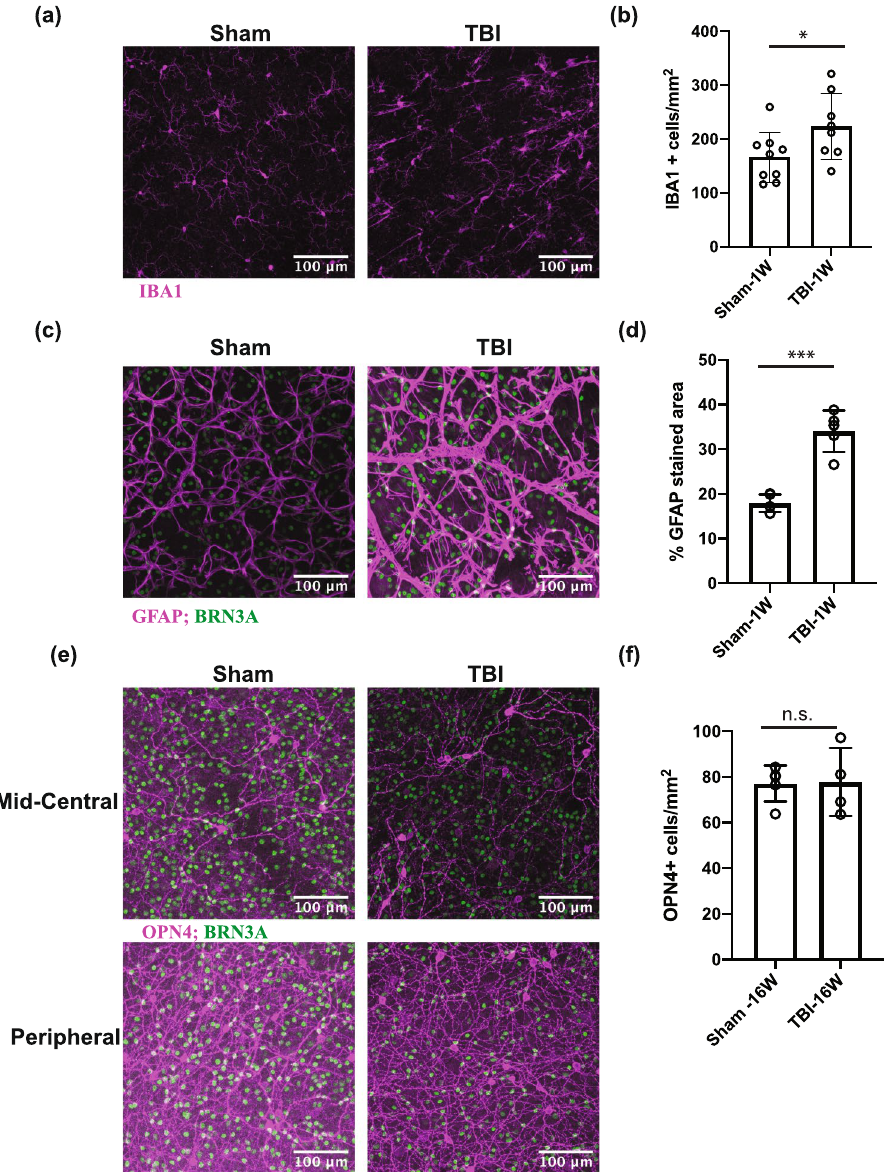
Figure 7. Blast-mediated injury resulted in a significant increase in the number of microglia in the retina within one week. ( a ) Images from the mid-central area of whole-mount retinas stained with anti-IBA1 antibody (pink) at 1 week (1 W) post-injury, for sham and bTBI-treated mice. ( b ) Quantification of IBA1 + cells at 1 W after injury. ( c ) Images from the mid-central area of whole-mount retinas stained with anti-GFAP antibody (pink) and anti-BRN3A antibody (green) at 1 W post-injury, for sham and bTBI-treated mice. ( d ) Quantification of GFAP + area 1 W after injury. ( e ) Images from the mid-central and peripheral areas of whole- mount retinas stained with anti-OPN4 antibody (pink) and anti-BRN3A antibody (green) at 16 weeks (16 W) post-injury for sham and bTBI-treated mice. ( f ) Quantification of OPN4 + positive cells at 16 W after injury. Bars represent mean ± SD and each data point represents a biological sample; unpaired two tailed t -test analysis with Welch’s correction, * p < 0.05, ***p<0.001, n.s. not significant. The images were processed in Fiji 111 , the graphs were generated in Prism 8 software and the figure was assembled in Adobe Illustrator CC